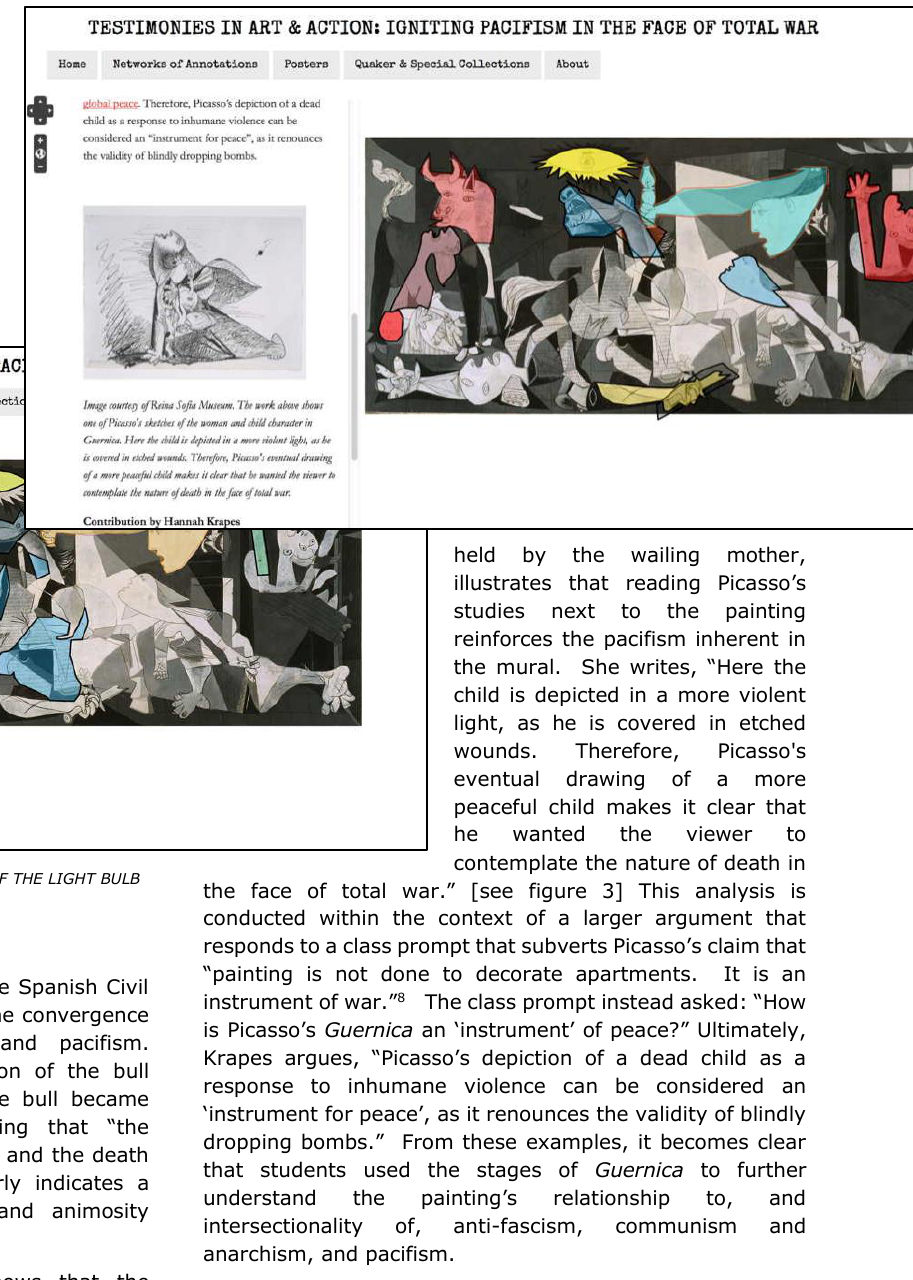
FIGURE 3: HANNAH KRAPES PROVIDES A PACIFIST UNDERSTANDING OF GUERNICA THROUGH EXAMINING THE STUDIES